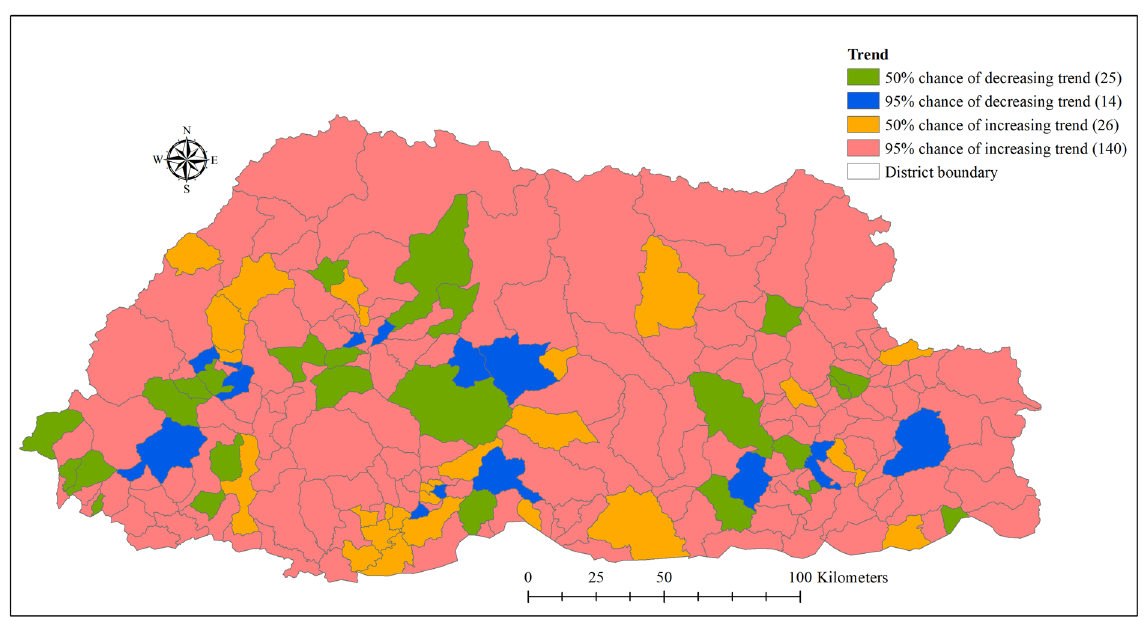
Figure 4. Trend analysis of common colds by sub-district in Bhutan (January 2010–December 2018) based on the spatio-temporal random effect of a Bayesian